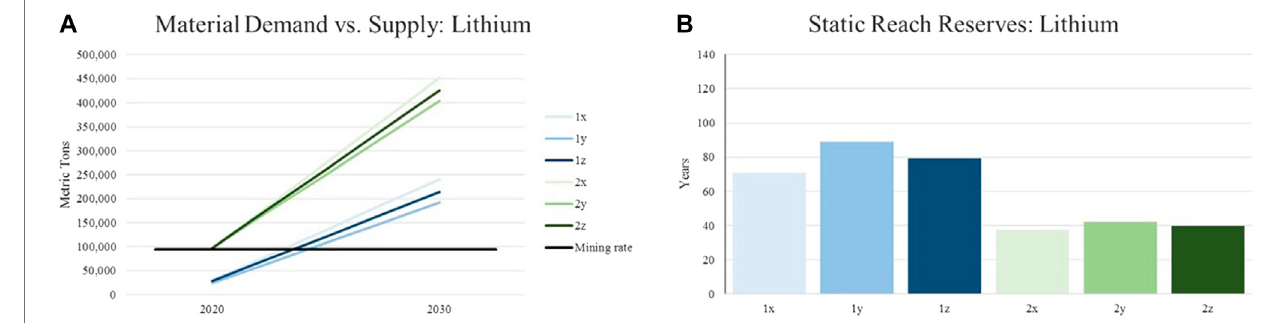
FIGURE 3 | Analysis of lithium raw material availability.